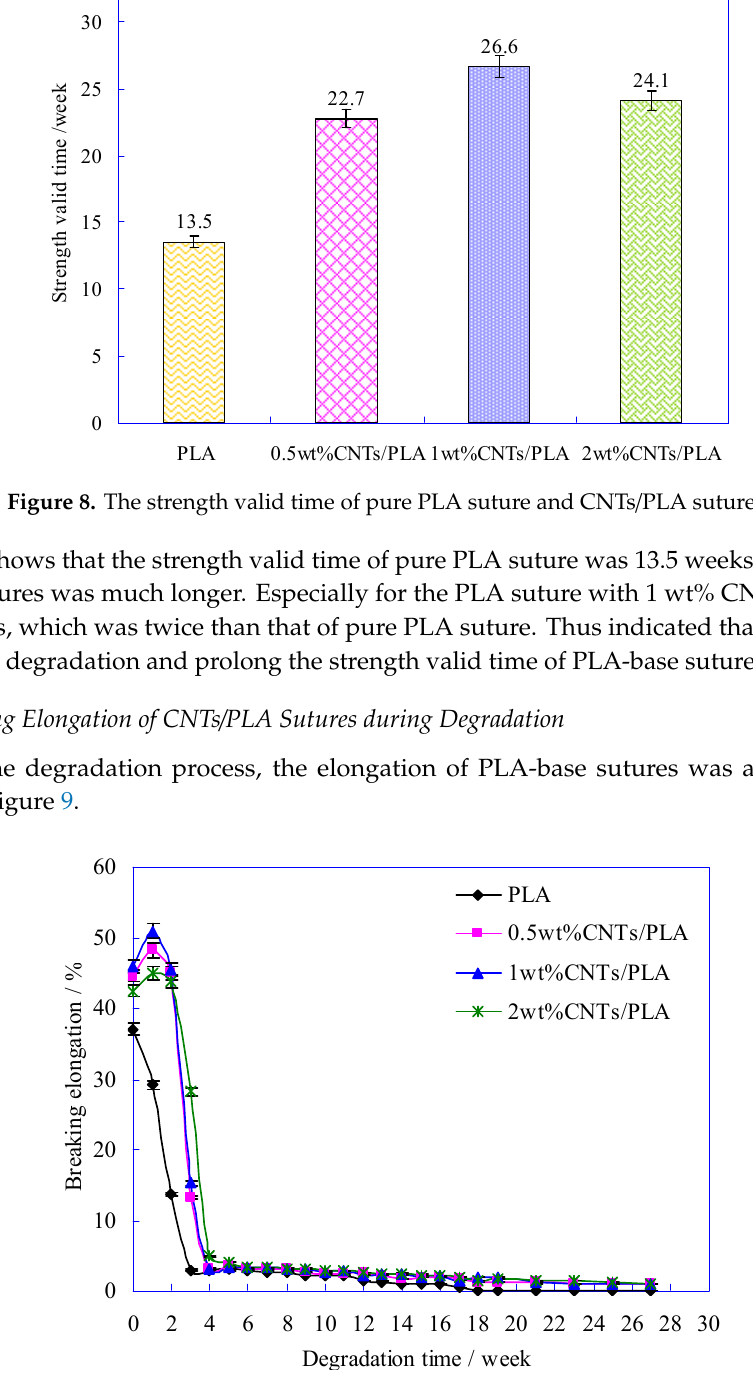
Figure 9. The variation of breaking elongation of PLA-base sutures with degradation time.